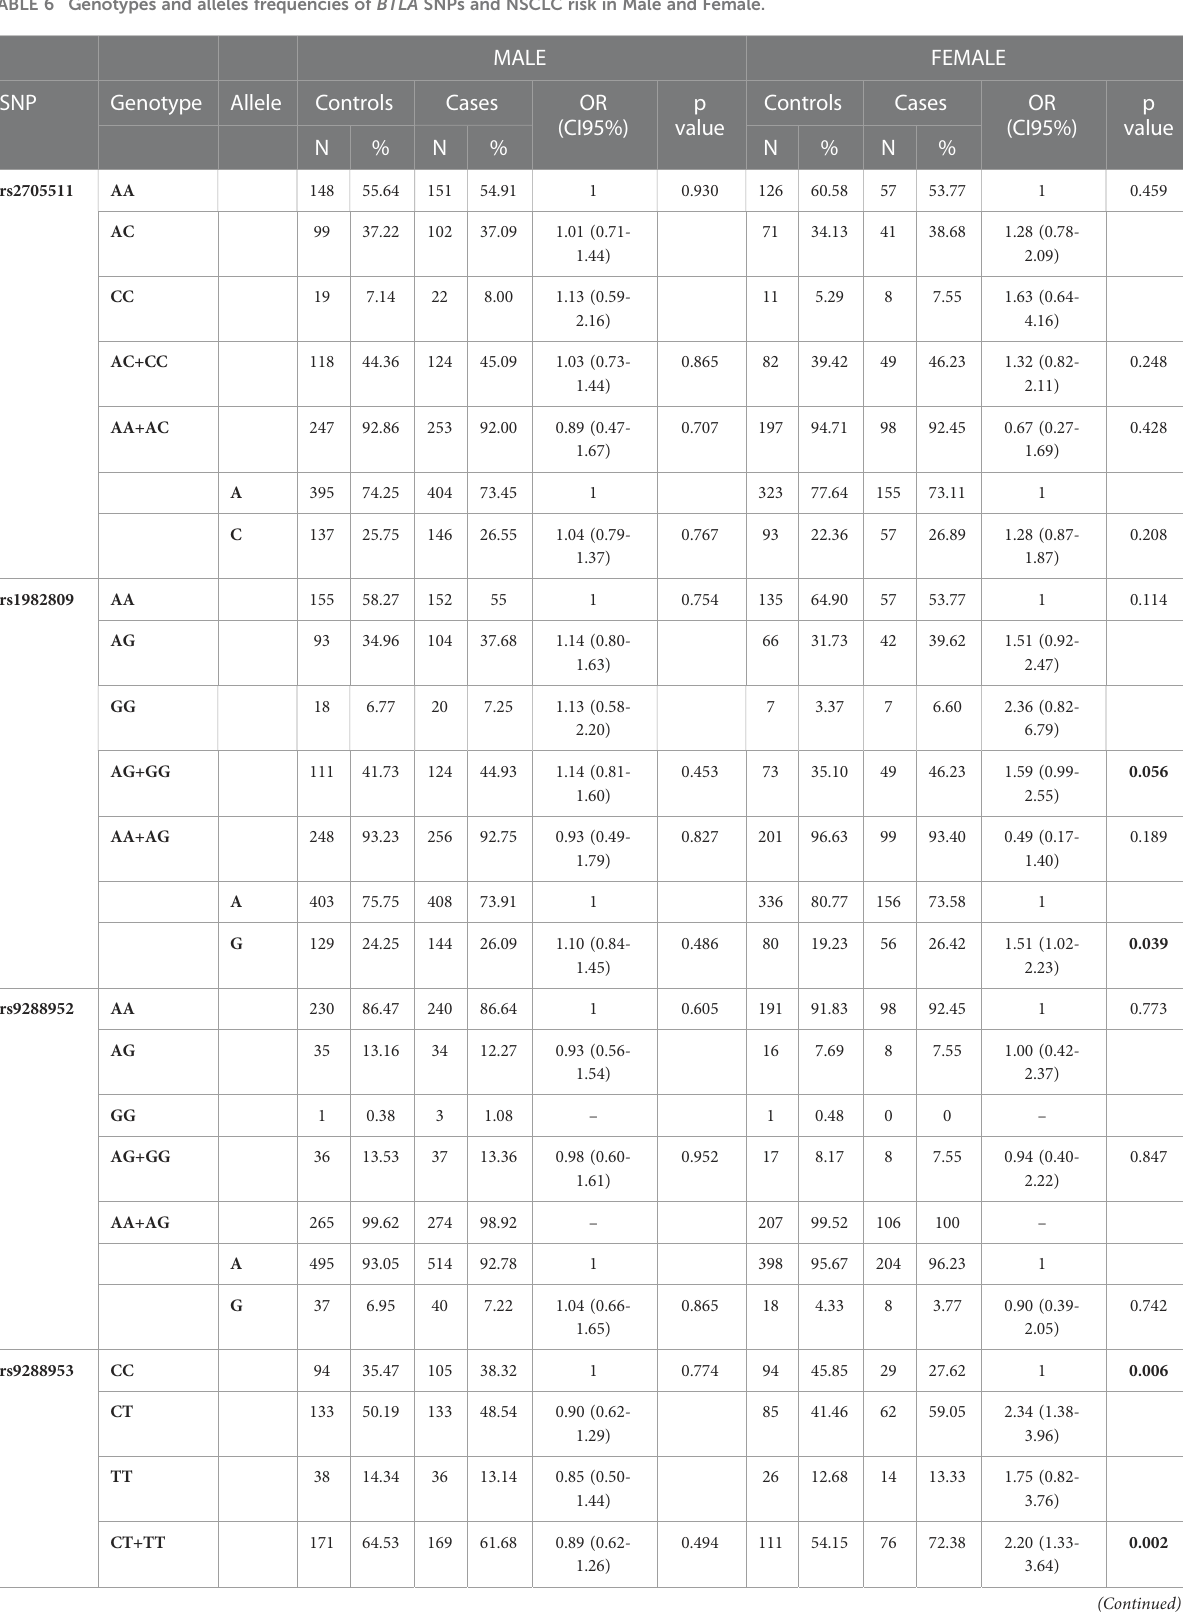
TABLE 6 Genotypes and alleles frequencies of BTLA SNPs and NSCLC risk in Male and Female. MALE FEMALE SNP Genotype Allele